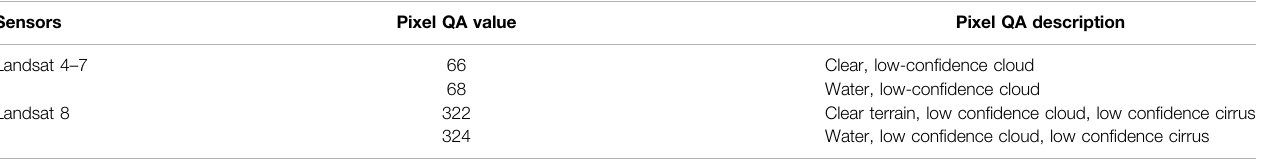
TABLE 1 | Pixel_qa values of “ clear ” pixels for Landsat 4, 5, 7, and 8 [extracted from Landsat 8 Collection 1 (C1) Land Surface Re fl ectance Code (LaSRC) Product Guide (USGS, 2020a; USGS, 2020b; USGS, 2020c)].